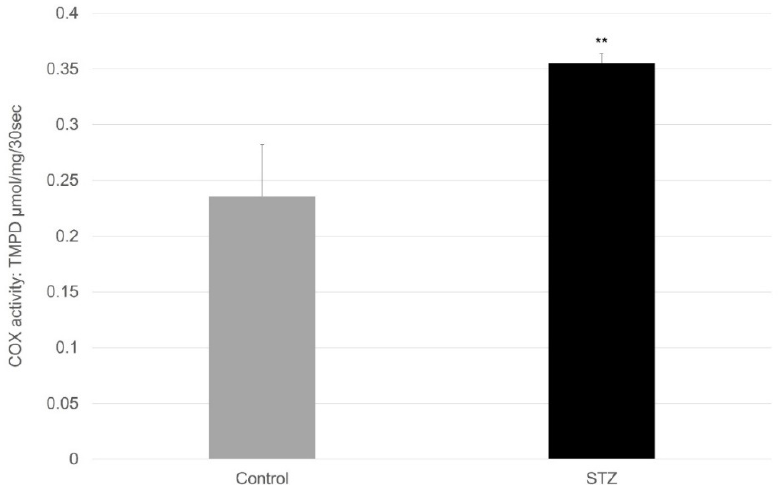
Figure 8. Activity of COX of the small intestine in control and diabetic rats. Values represent the mean ± S.E. of five rats. Each value represents the mean of 5 independent experiments ± standard error. **, p < 0.01 versus control. STZ, steptozotocin. The enzyme activity is expressed in μ mol TMPD/mg/min, which was conjugated in 30 s calculated for 1 mg protein of the small intestine.